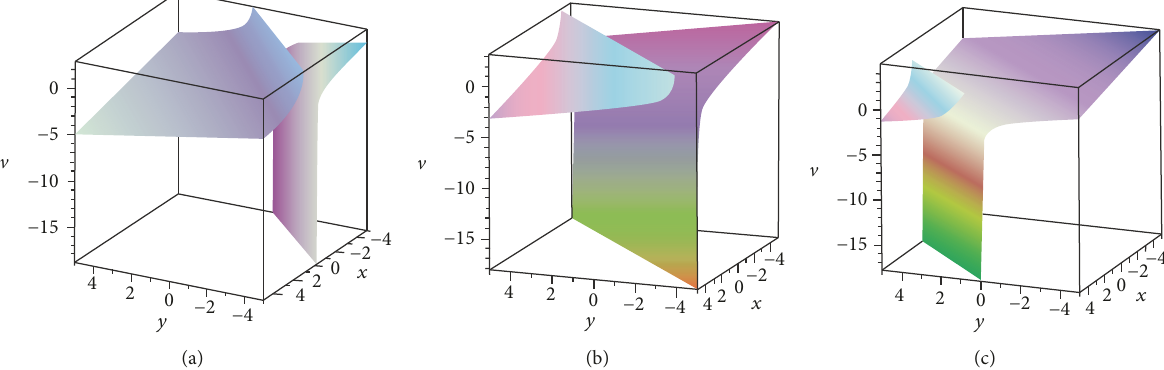
Figure 3: The solution of the (2 + 1)-dimensional Jaulent-Miodek equation corresponding to V 𝑟,2 (𝑧) , (a) 𝑡 = −5 , (b) 𝑡 = 0 , and (c) 𝑡 = 5 .